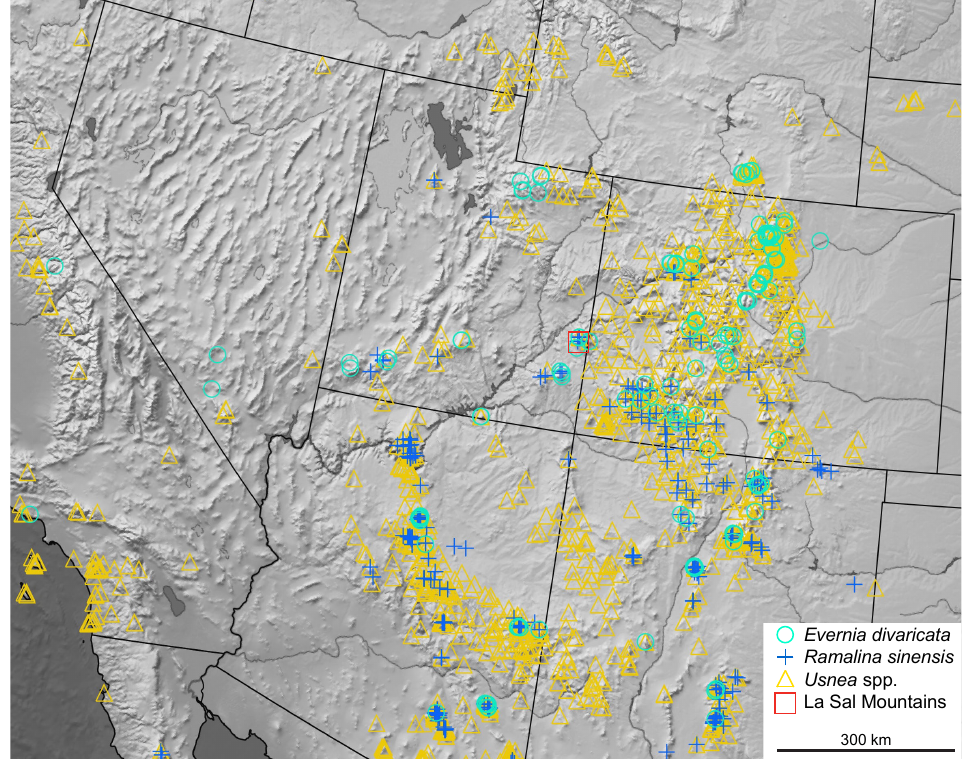
Figure 1. Distribution of fruticose lichens Evernia divaricata , Ramalina sinensis , and Usnea species across the Intermountain West region of the USA. The La Sal Mountains are located in southeastern Utah near the state border with Colorado—indicated by red box. Species distribution records